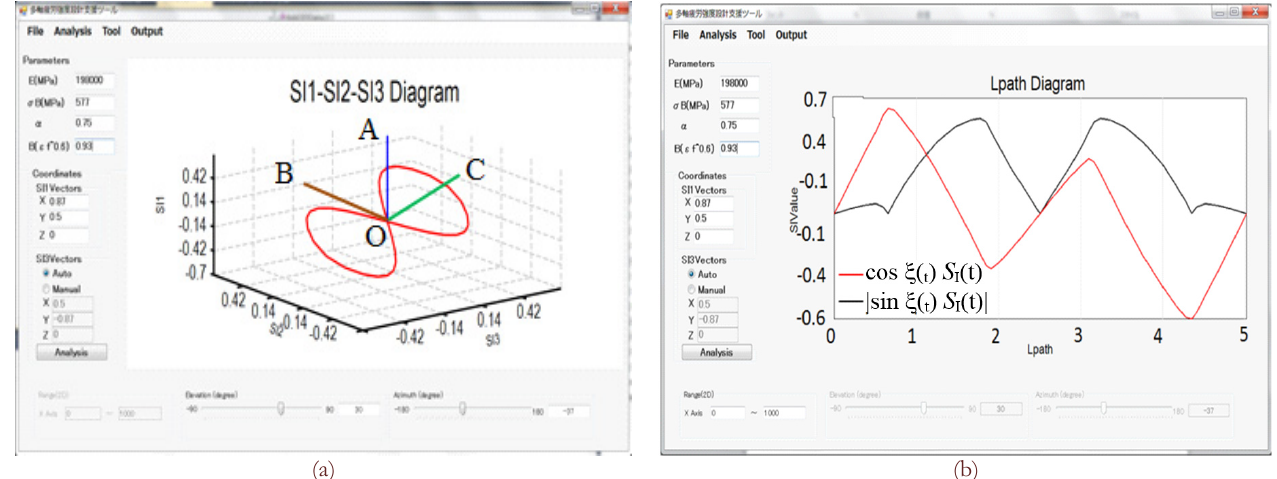
Figure 15: Output strain path in polar coordinates and waveforms: (a) Strain path in polar coordinates. (b) Strain waveforms projected to reference